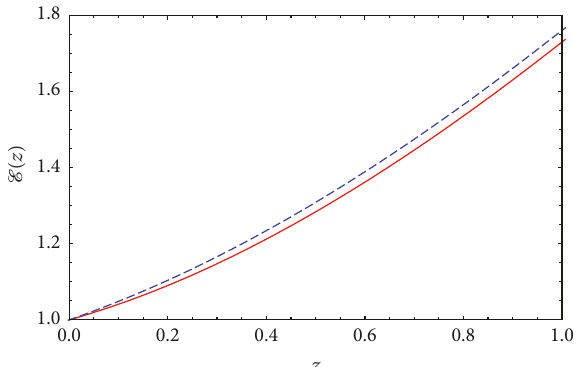
Figure 2: Behaviors of our model and Λ CDM normalized Hubble rates E , with indicative values Ω 𝑚,0 = 0.3 and 𝛽 as reported in